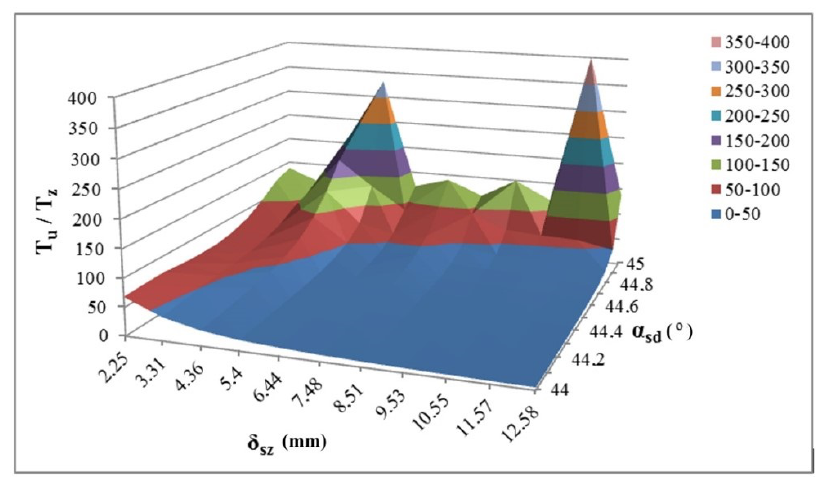
Figure 5. 3D graph for the T u /T z coefficient for the asymmetric DCPM motor.